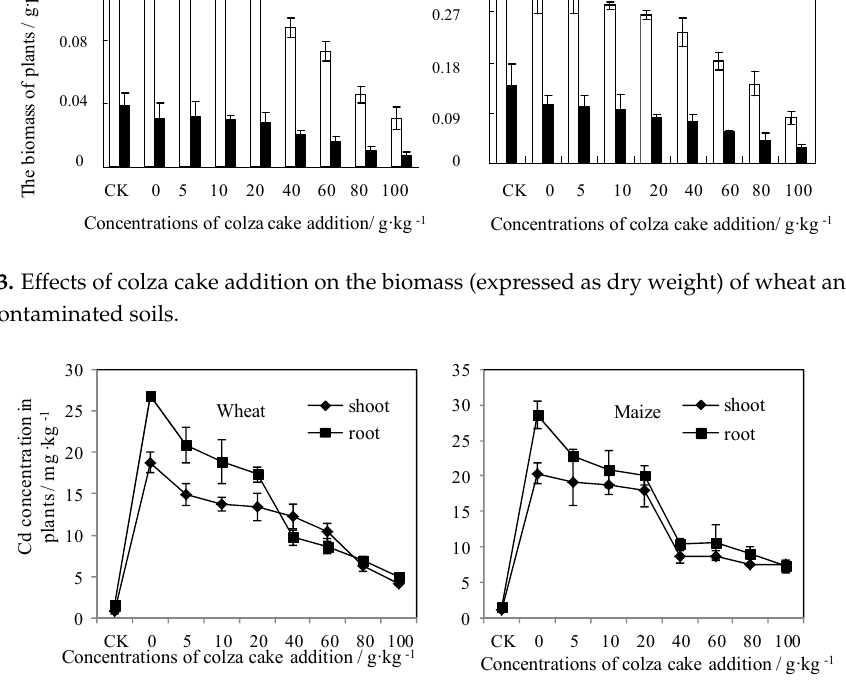
Figure 4. Cadmium concentrations in plant tissues of wheat and maize after the addition of colza cake in Cd-contaminated soils.